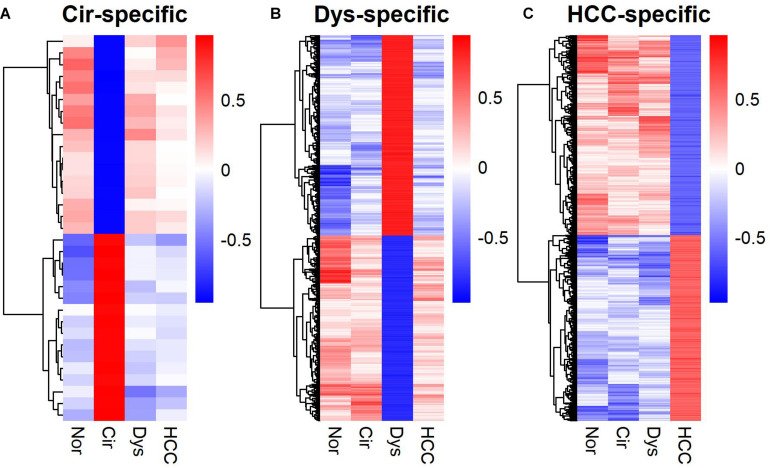
Heat-maps for stage-specific co-expression networks of lipid metabolic genes. (A) Cirrhotic-specific co-expression. (B) Dysplastic-specific co-expression. (C) HCC-specific co-expression. The Pearson’s correlation coefficients are color-coded as depicted in the sidebar. The co-expressed gene-pairs in the heat-maps are provided in Supplementary Table S3.